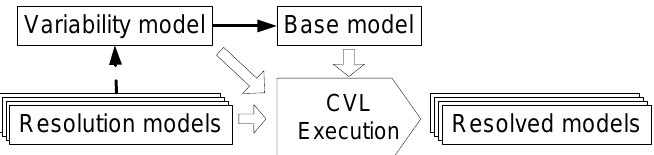
Figure 1. Common Variability Language (CVL) as specified in